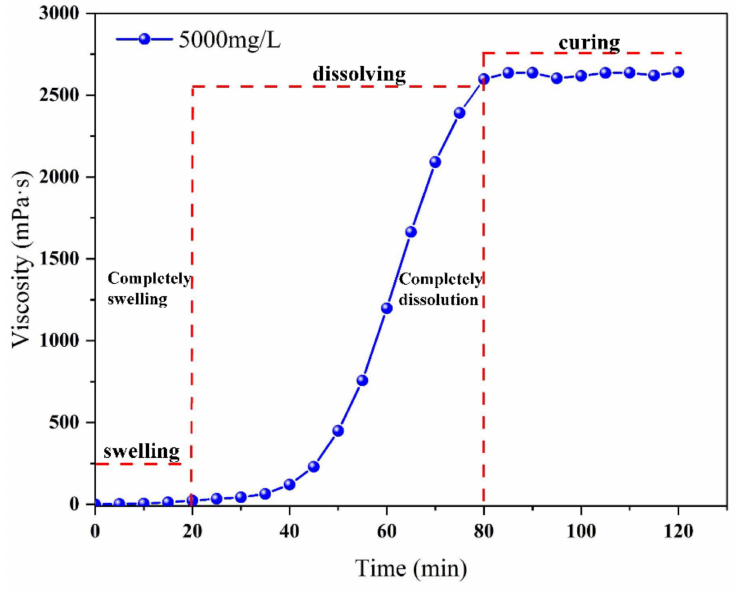
Figure 1. Polymer dissolution process of AP-P4.